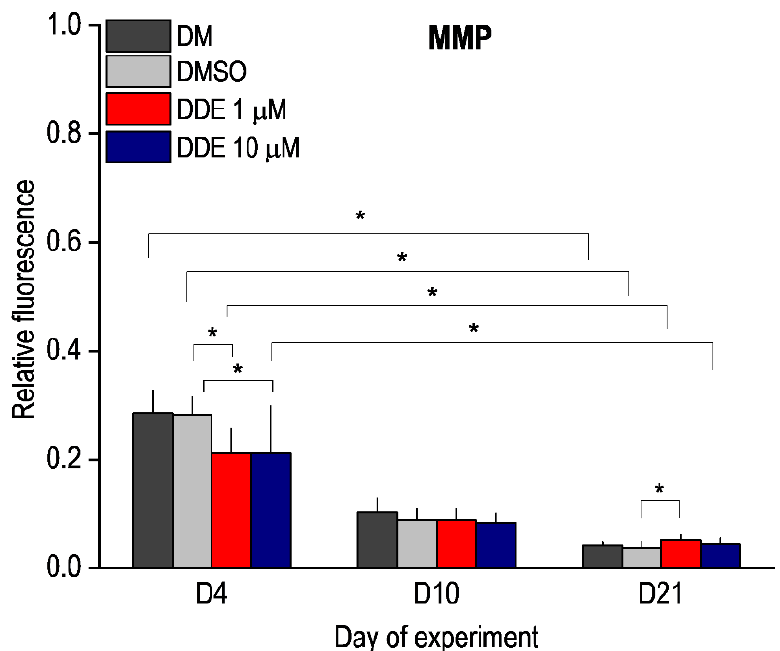
Figure 7. Mitochondrial membrane potential (MMP) during adipocyte differentiation in media containing no additive (DM) or DMSO, DMSO, and 1 µ M p,p’-DDE, and DMSO and 10 µ M p,p’-DDE on days 4, 10, and 21 of the experiment. Significant differences * p < 0.05 (Friedman and Wilcoxon rank sum tests). On the fourth day of differentiation, a significant decrease in MMP was observed in DDE-affected cells at both 1 μ M and 10 μ M concentrations compared to medium containing DMSO alone. In cells affected with 1 μ M DDE, there was a significant increase in MMP on day 21 of differentiation compared to control cells exposed to DMSO alone.